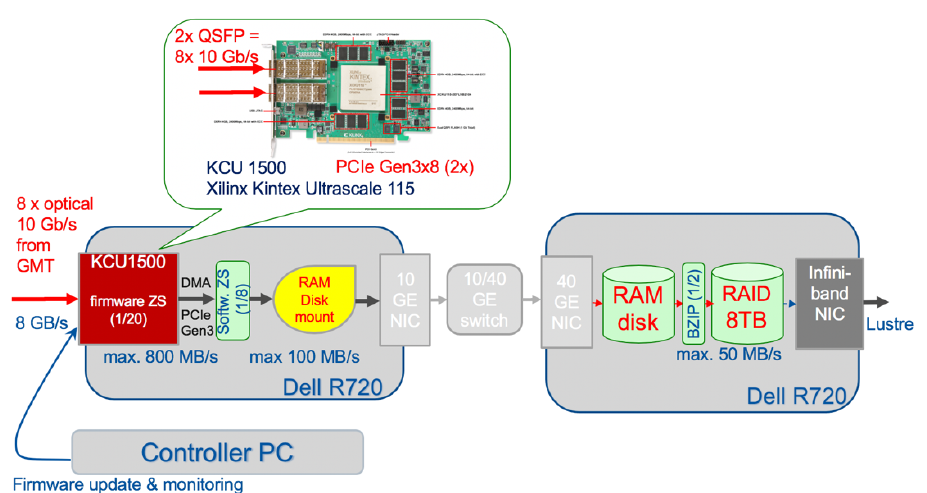
Fig. 3. Prototype scouting system deployed at the end of Run-2. ZS: Zero Suppression